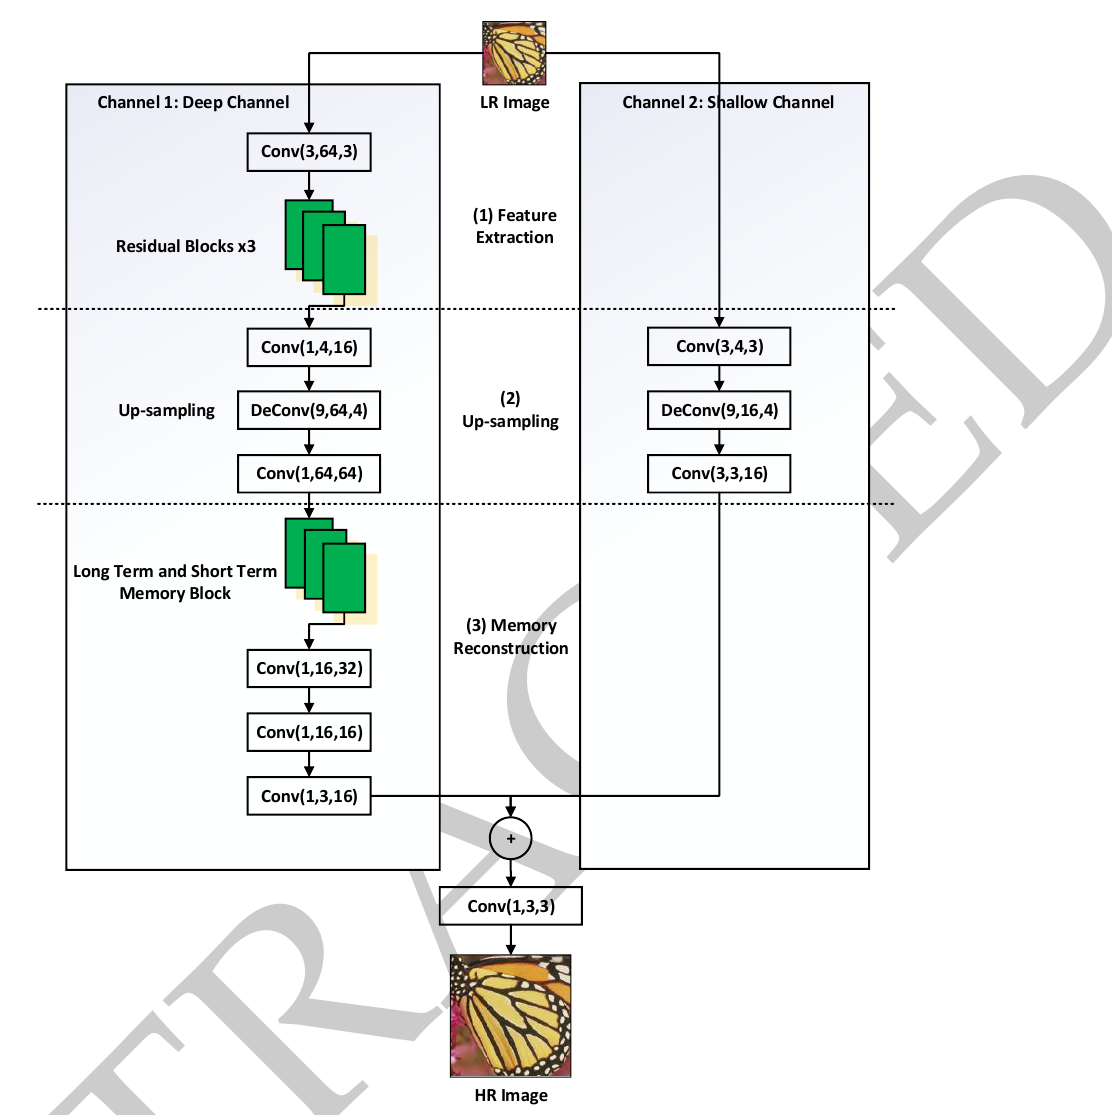
Figure 2. The processing procedure of Dual-Channel Convolutional Neural Networks (DCCNN).